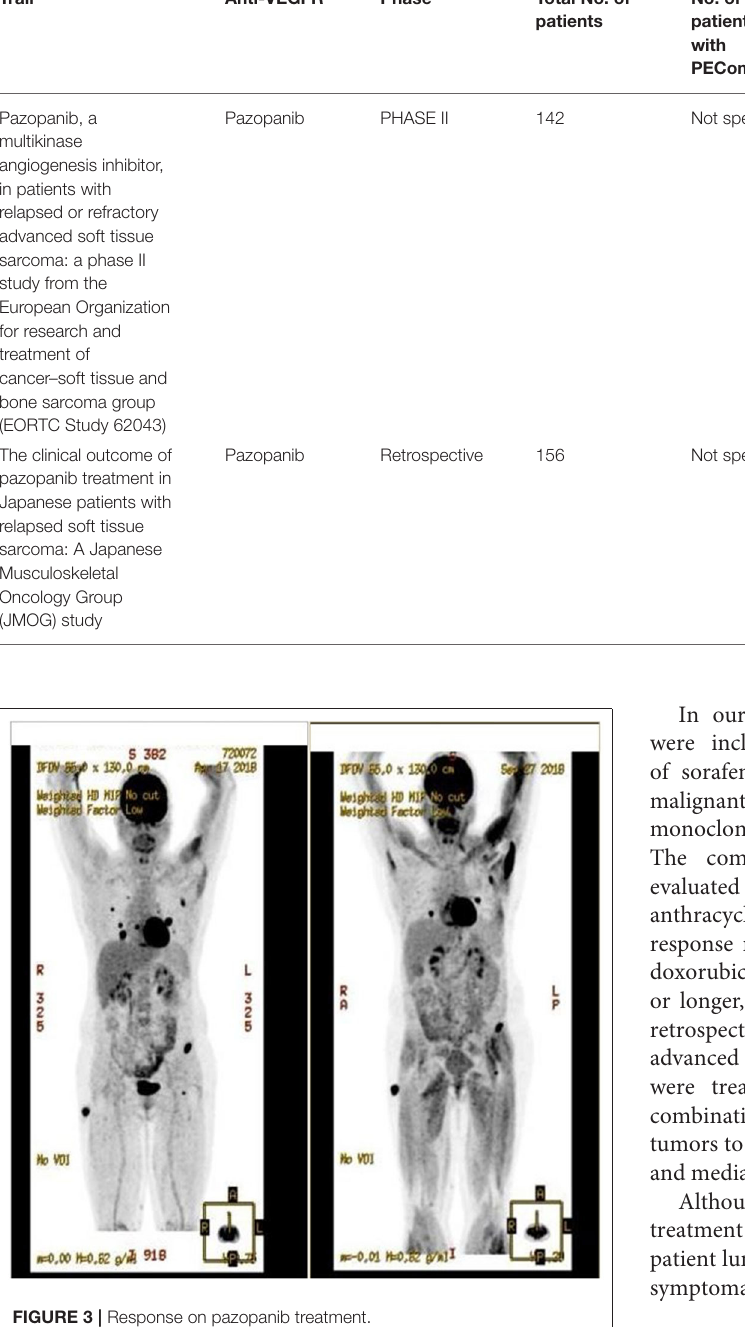
FIGURE 3 | Response on pazopanib